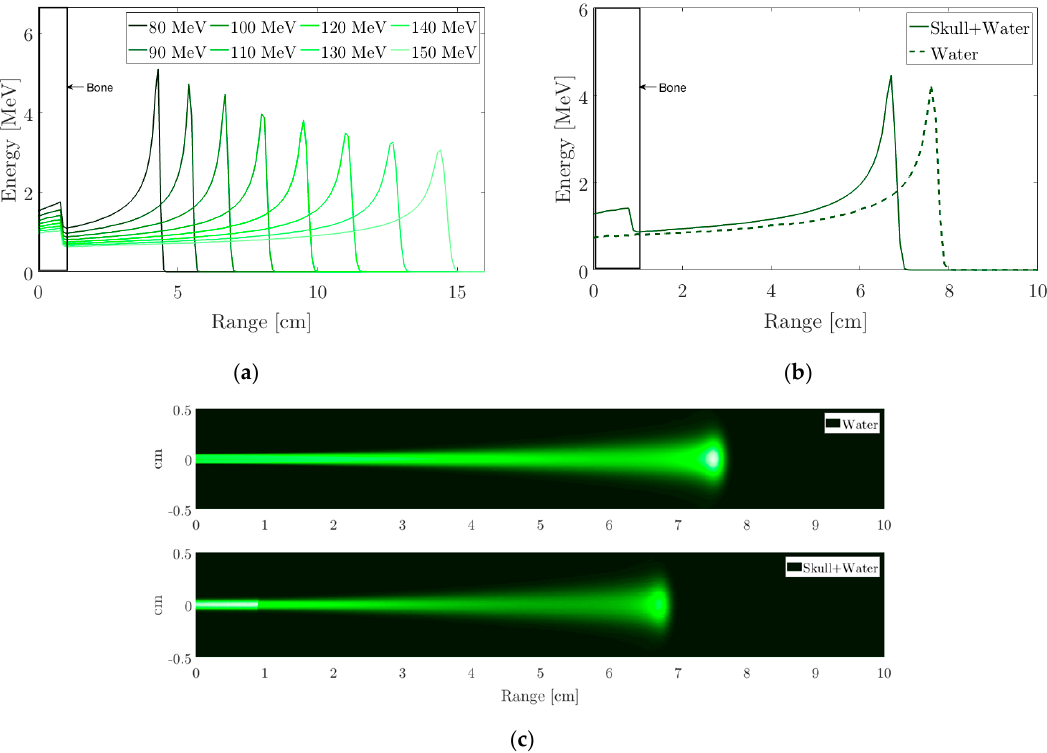
Figure 4. Energy deposition for a proton beam with Gauss profile ( σ = 1 mm) and 10 6 protons. ( a ) layer bone interaction with different beam energies; ( b ) Interaction with the water phantom and with a 1 cm bone layer; ( c ) Deposition in a plane for 100 MeV, the upper figure shows the phantom water and the lower one shows the interaction with a layer of bone.